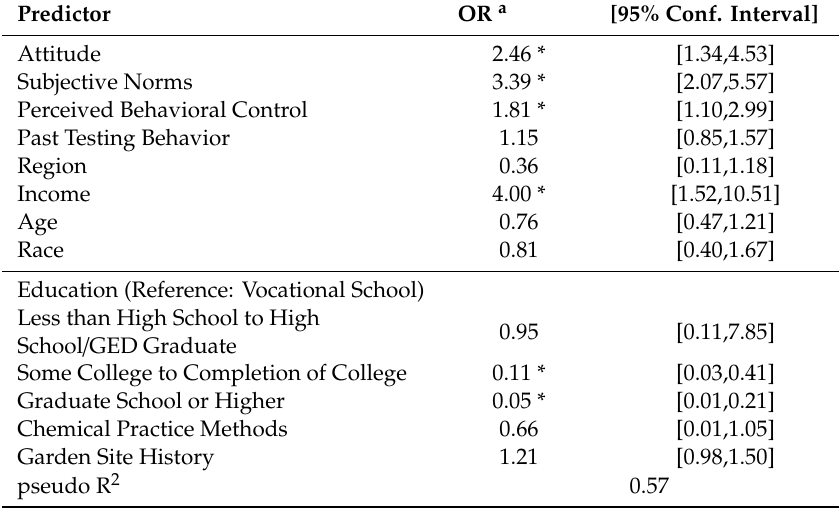
Table 4. Predictors of Soil Testing